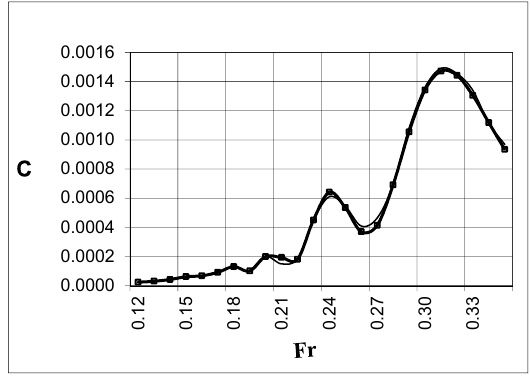
Figure 2. Testing of the long model. L/B = 36, 7. Points show the calculated results.